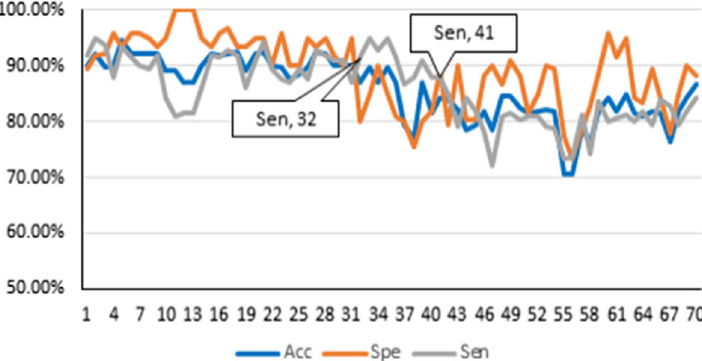
The bold part represents the best result among different time parts for Acc, Spe and Sen